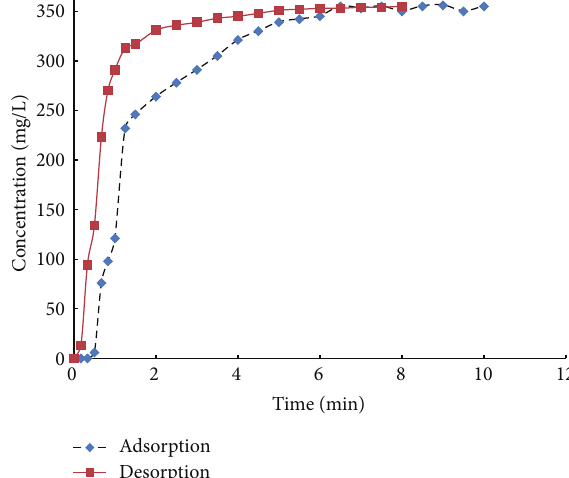
Figure 7: Adsorption-desorption curves for CO 2 . Reaction condi- tions: initial CO 2 concentration of 350 mg/L, CO 2 /N 2 flow rate of 0.3 L/min, 1.5 g ash, 20% RH, 1atm, and 22 ∘ C.